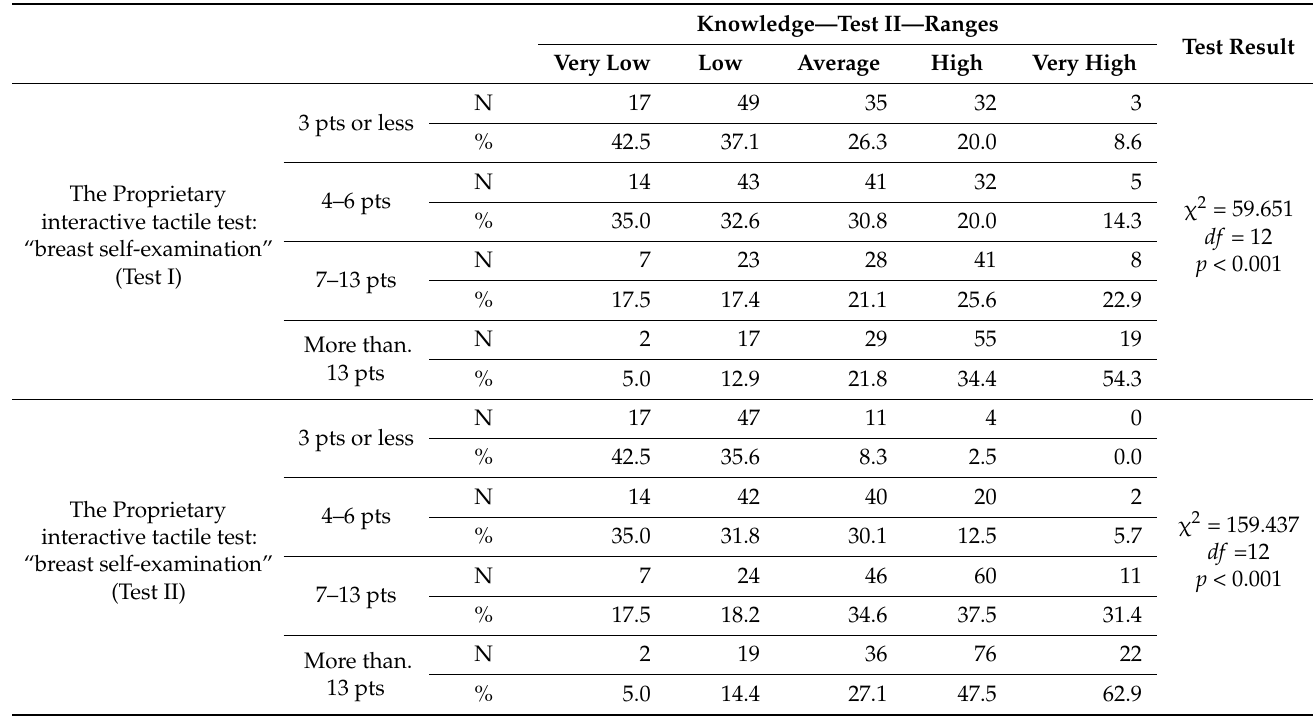
Table 12. Knowledge in Test II and the number of tested points in the proprietary interactive tactile test in Tests I and